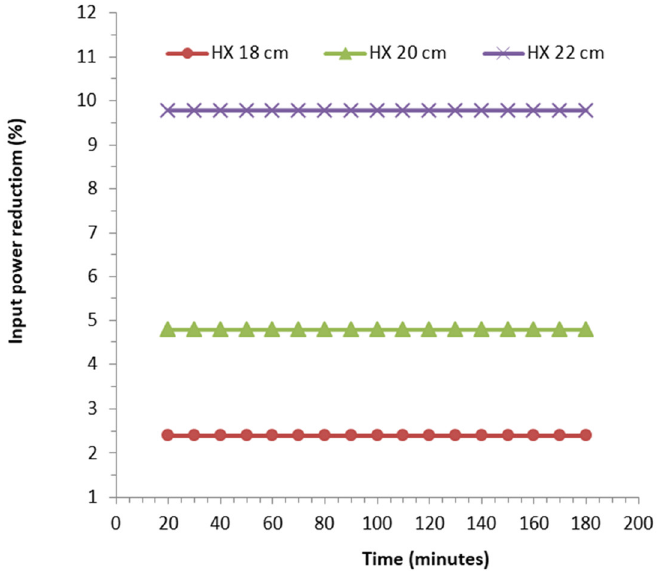
Figure 11. Input-power reduction of the air conditioner using subcooler for three different lengths of heat exchanger.